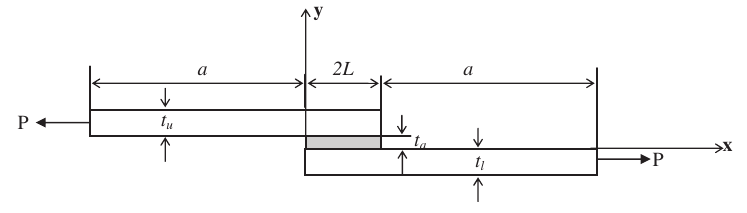
Figure 1 Geometry of single-lap Joint ( a = 50